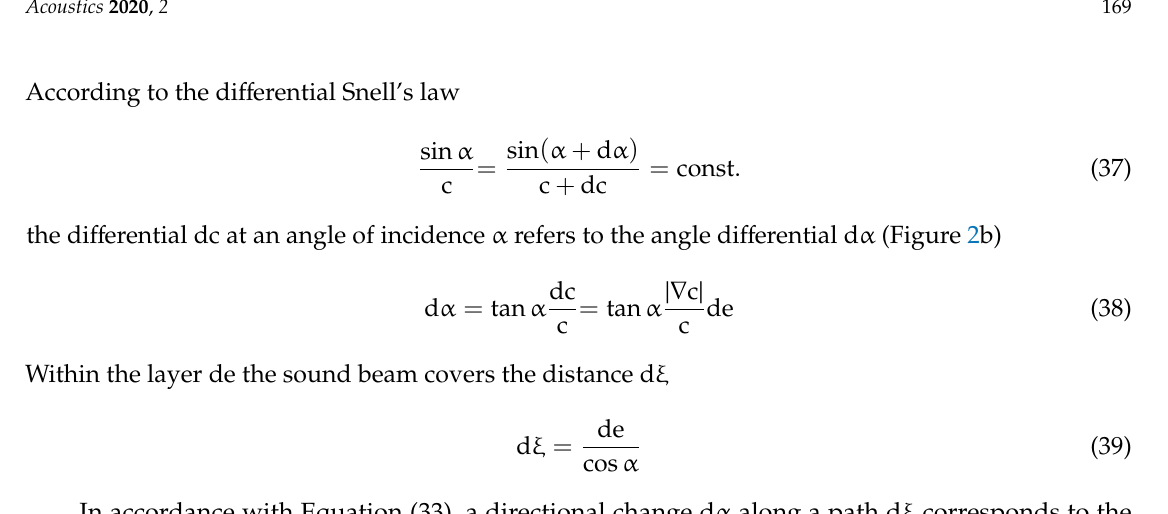
Figure 1. 1D-waveguide with sinusoidal wave propagation (single waveguide element is displayed): Two-way wave equation with two solutions according to the wave velocities + c and – c vs. One-way wave equation with one unique solution acc. to the chosen wave velocity c (here: + c ).